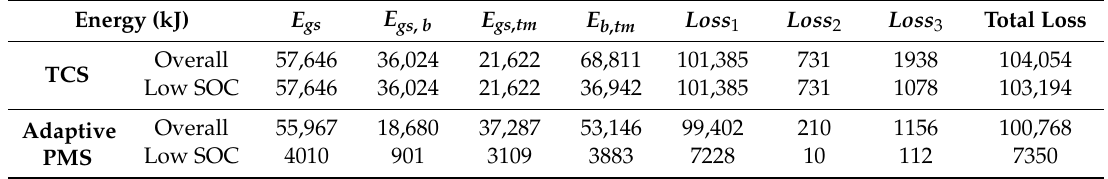
Table 7. Energy usage comparison of TCS and adaptive PMS for 10